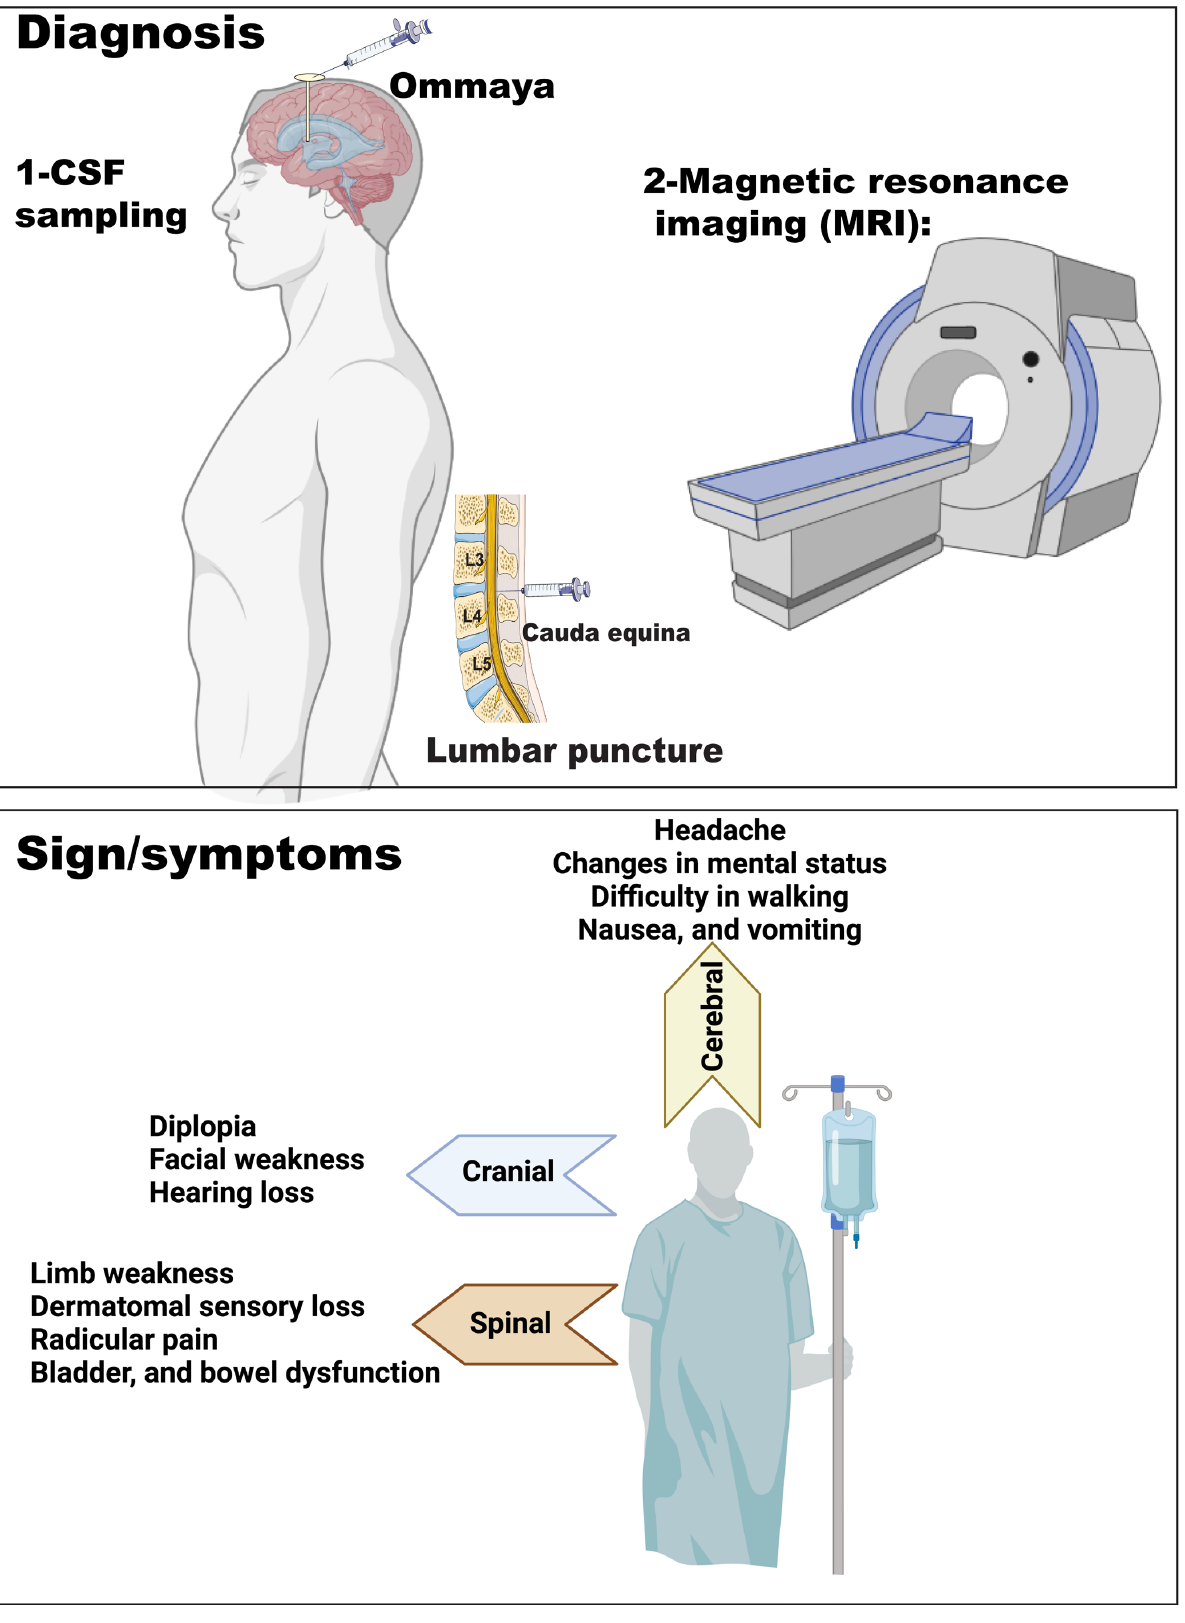
Figure 3. Diagnosing LMD ( upper panel) using CSF sampling and MRI. Signs/symptoms in LMD ( lower panel) depending on the location(s) of CNS